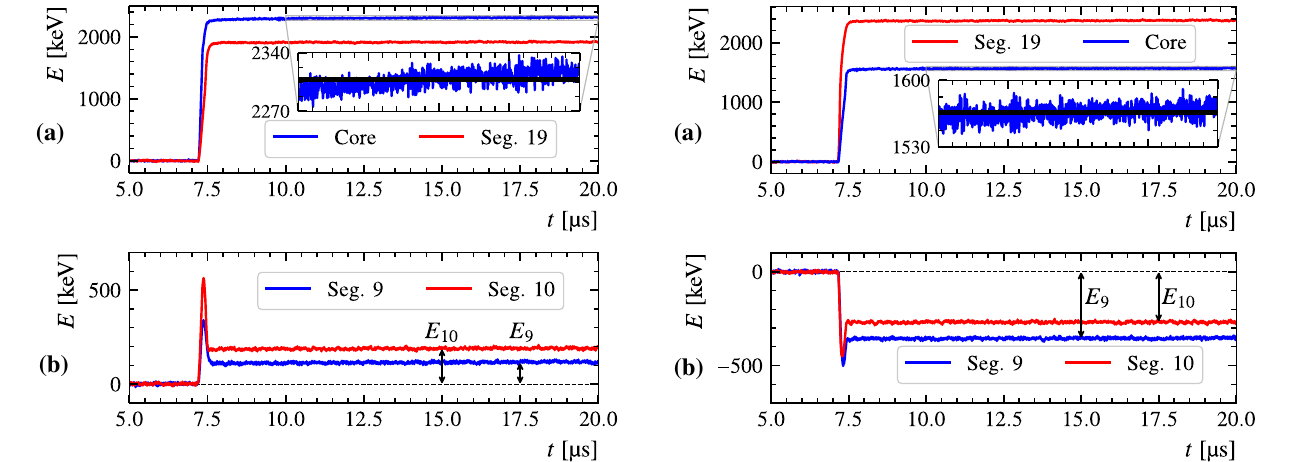
Fig. 9 Pulses of a typical event with net hole trapping of the a core and segment 19 and b the two closest segments 9 and 10 of a measurement from RSS at ϕ = 180 . 6 ◦ and r = 18 . 8mm. The observed energies, E 9 and E 10 , are also indicated. The horizontal line in the inset in a is at the mean of the tail of the core pulse